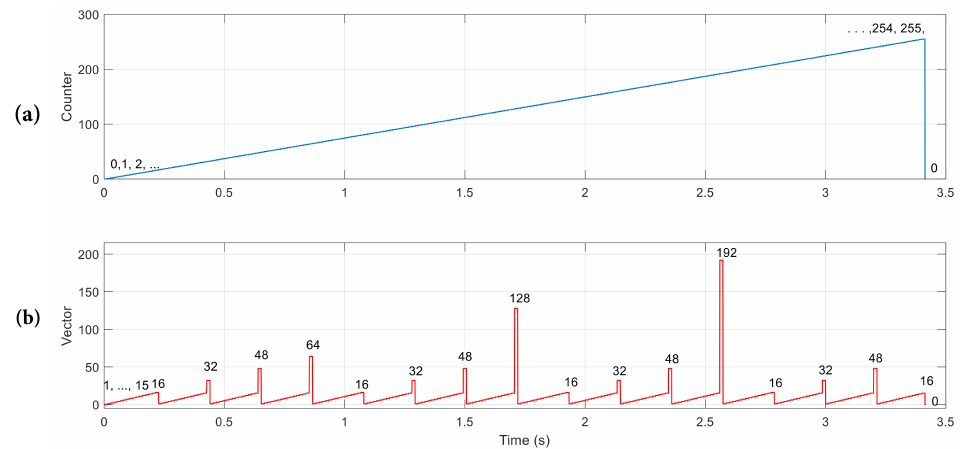
Figure 35. Sixth set of simulation results, ( a ) Incremental counter input and ( b ) start-up test ouput value.